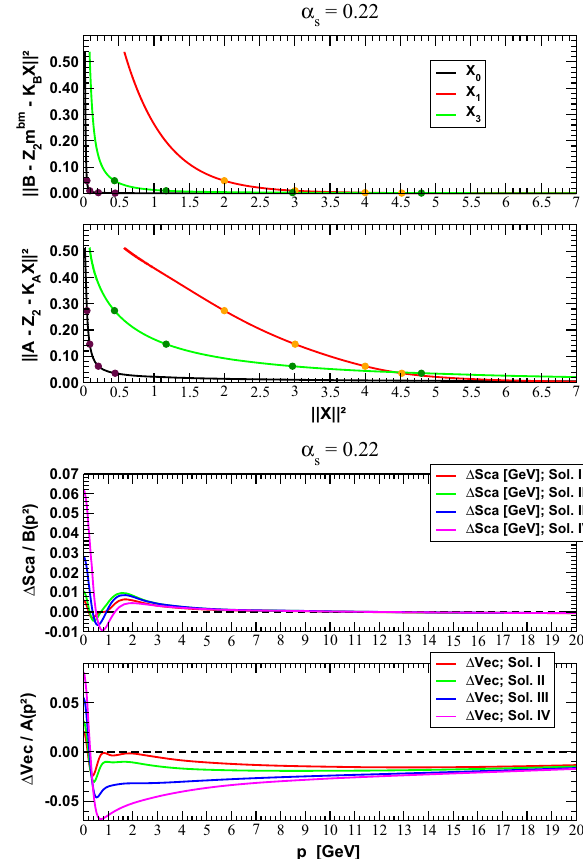
Fig. 30 NormversusResiduum(top)andrelativeerrorofthesolutions of the gap equation for α s (μ) = 0 . 20. The solutions on the right plot are those marked on the left plot with I being that associated to the most right mark in Sect. 6.2. Moreover, of the various solutions considered, remainingsolutionsgivenonFigs.25,30,31and32arelarger